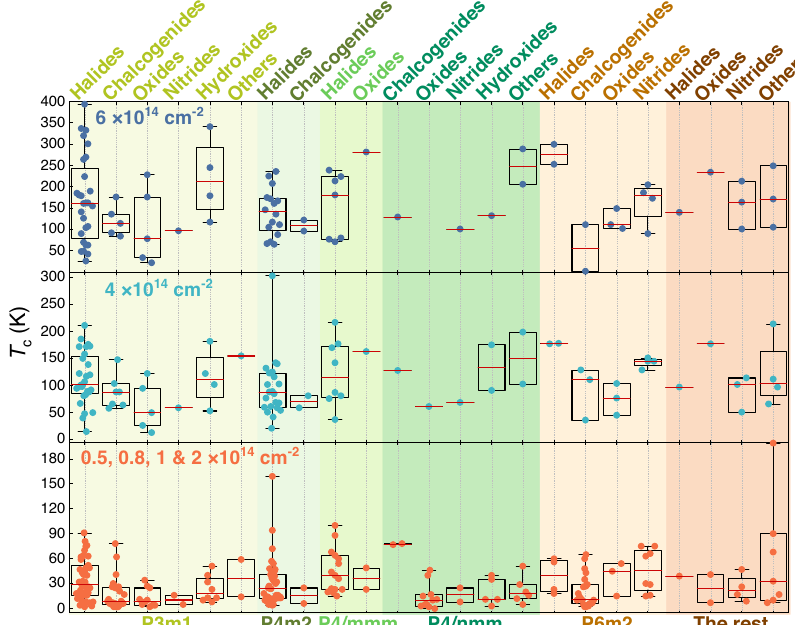
Fig. 4 Distribution of Curie temperatures of the 2DHDFM. Box plots of the Curie temperatures ( T c ) obtained from Monte Carlo simulations for 2DHDFM at different hole doping densities. The red lines inside the boxes represent the median values and the horizontal bar denotes the low/high boundaries of the spreads. The box plots show the extrema (whisker tails), interquartile range (box boundaries), and median (red horizontal